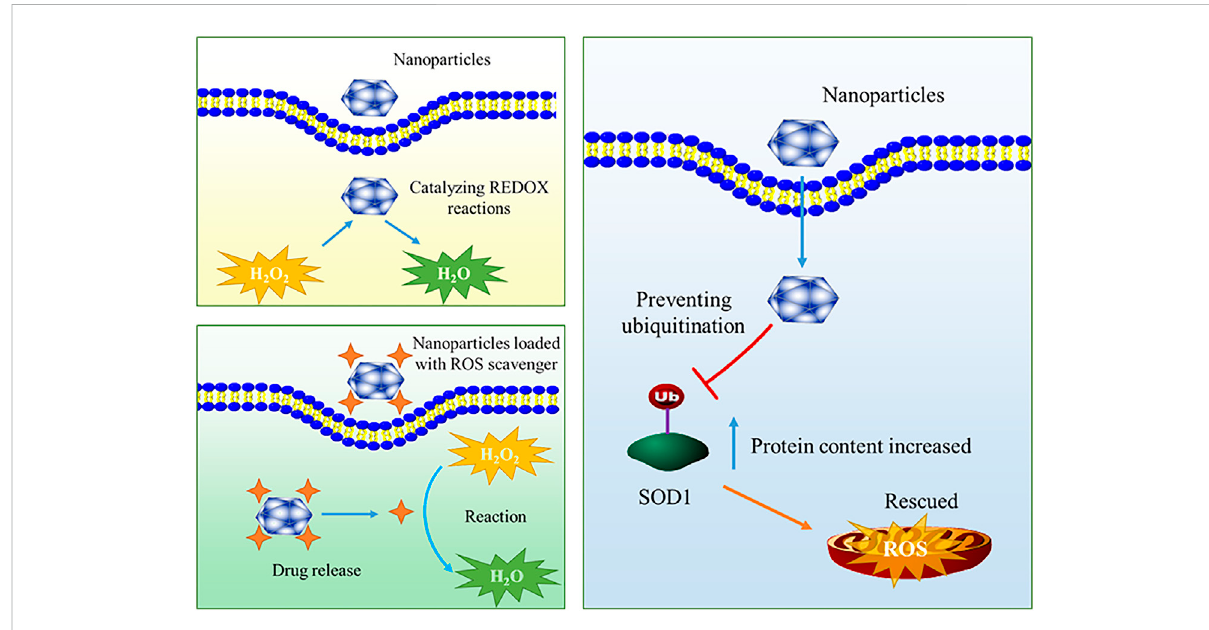
FIGURE 2 Overview of the mechanism of common ROS scavenging